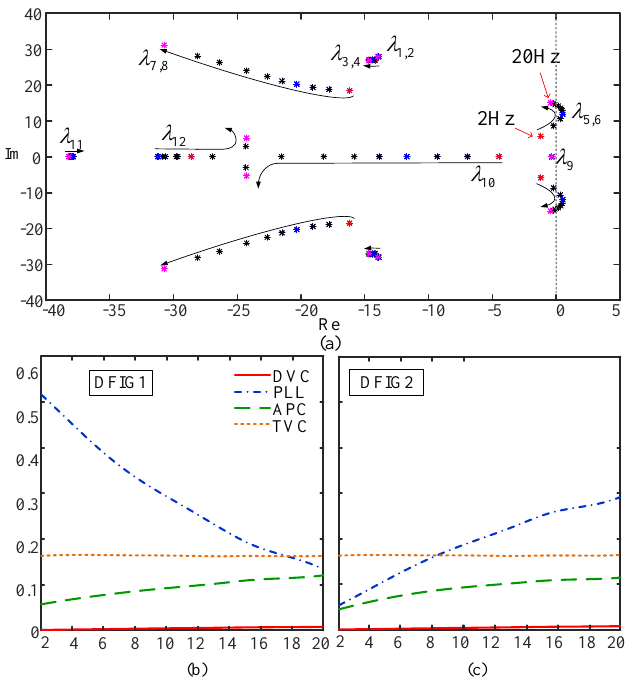
Figure 7. Stability analysis of a multi DFIGs system with different bandwidths of PLL. ( a ) Eigenvalue locus. ( b ) Participation factor curves for dominant mode in DFIG1. ( c ) Participation factor curves for dominant mode in DFIG2.